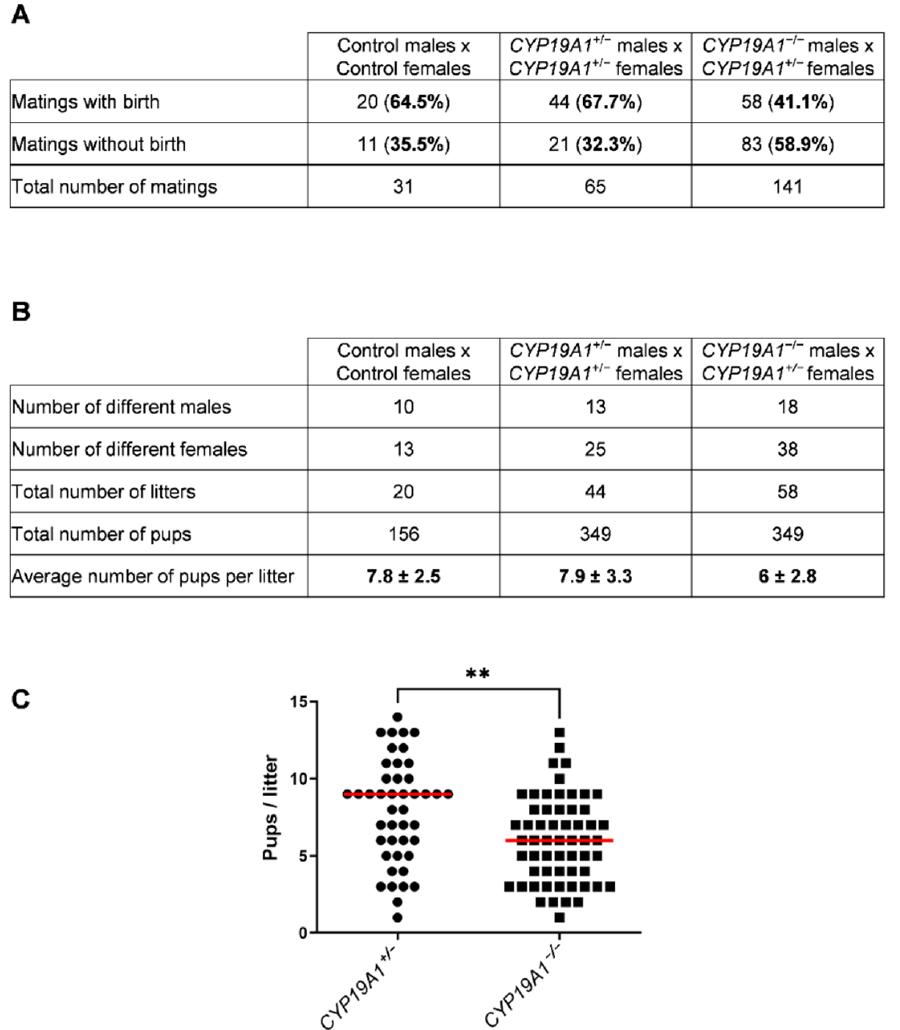
Figure 3. Effect of the CYP19A1 gene knock-out on the male fertility. ( A ) Number of successful and unsuccessful mating, depending on the genotype of the parents. ( B ) Number of different males and females used and pups per litter depending on the genotype. ( C ) Number of pups per litter obtained by crossing heterozygous females with heterozygous ( CYP19A1 +/ − ) or homozygous ( CYP19A1 − / − ) males. The median is shown in red. Mann–Whitney test: ** p <